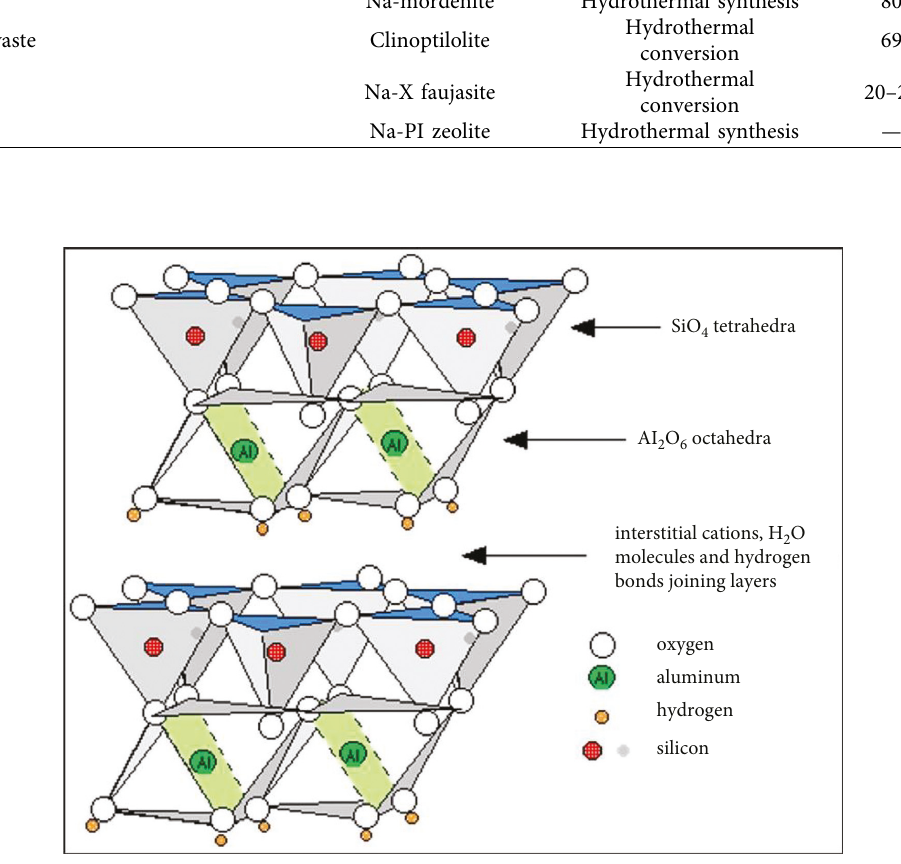
Figure 5: Structure of kaolinite (adapted from